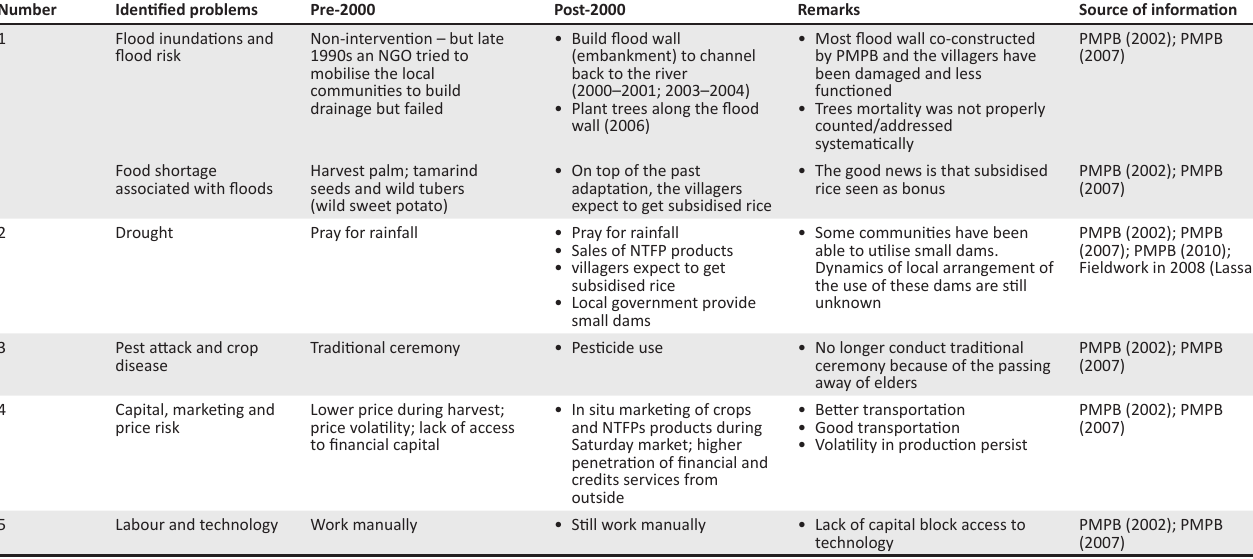
TABLE 3: Hazard and problem ranking. Number